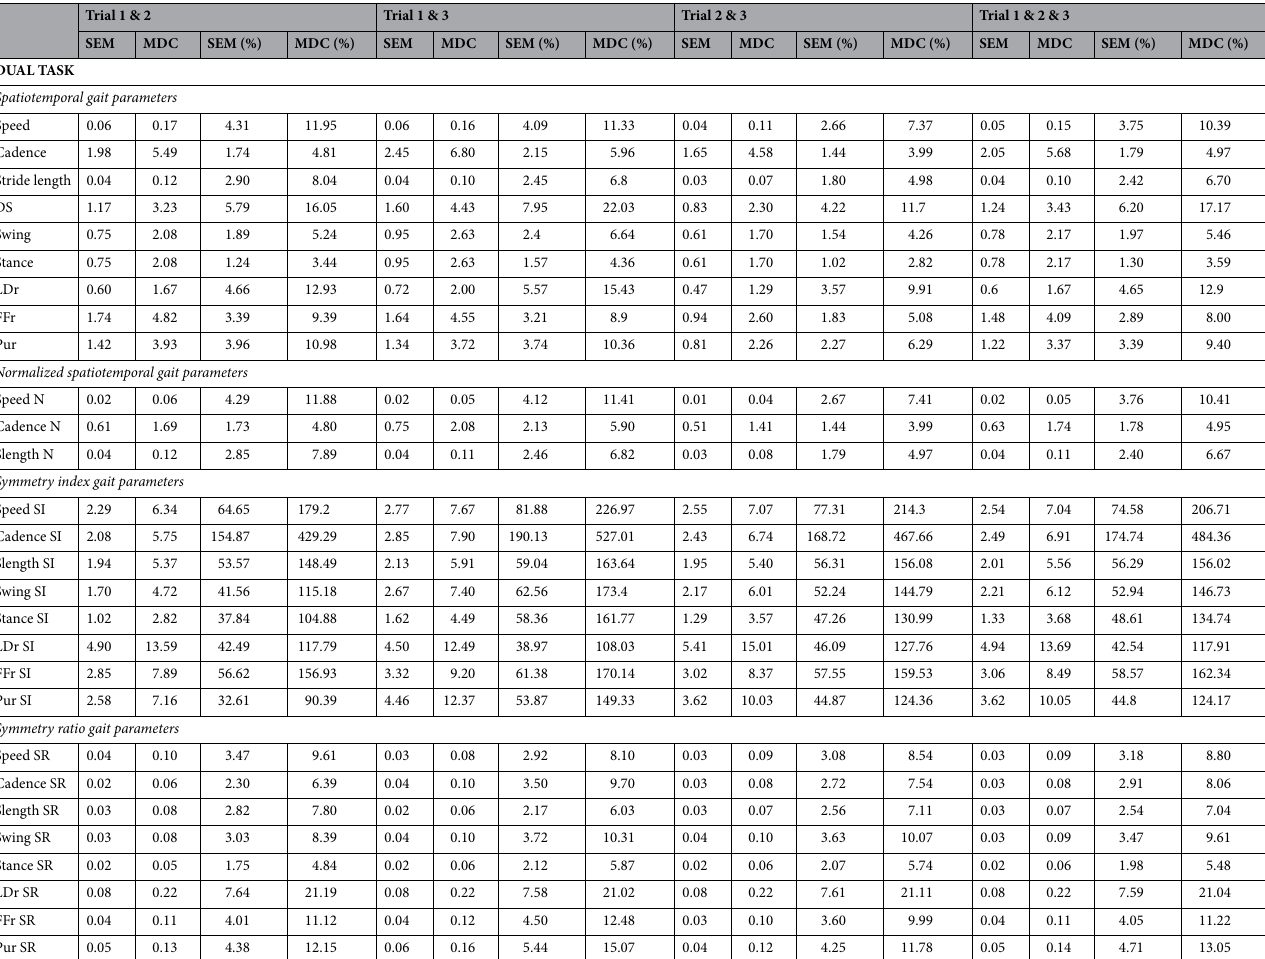
Table 5. Standard error of measurement (SEM) and minimal detectable change (MDC) for trial 1 and 2, 1 and 3, 2 and 3 and 1, 2 and 3 in dual task condition. Abbreviations: SEM = standard error of